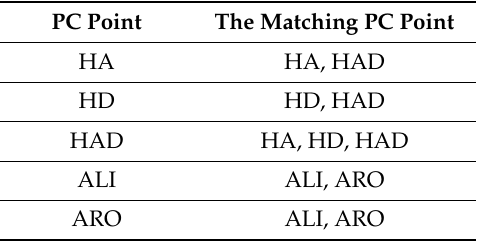
Table 1. Matching rule of the physicochemical